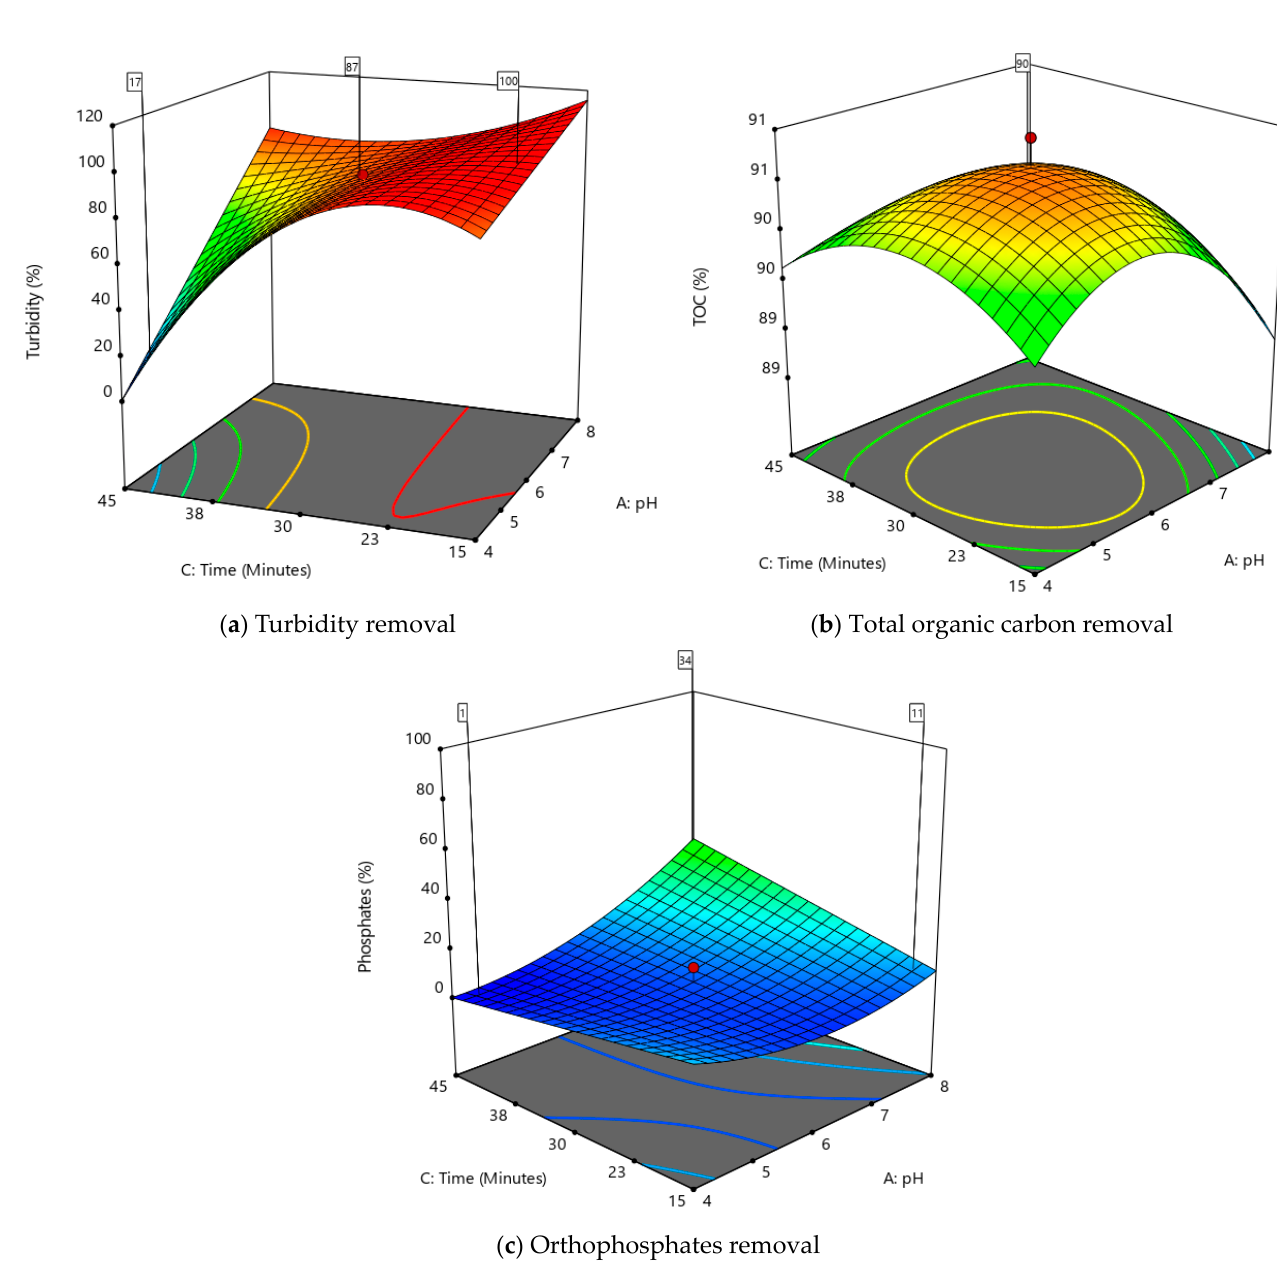
Figure 2. Response on the interactive effect of contact time and pH on the removal of ( a ) turbidity, ( b ) total organic carbon, and ( c ) orthophosphates .